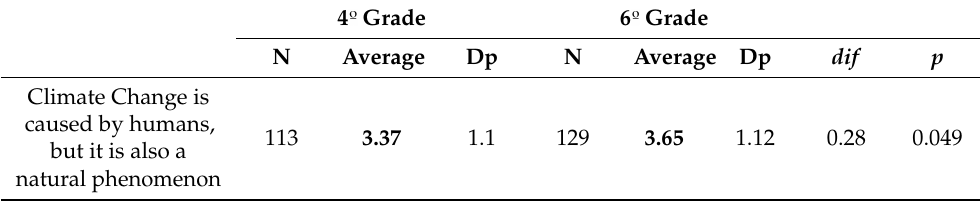
Table 7. Frequency table, grade 4 vs. grade 6, regarding the question: Climate change is caused by humans, but it is also a natural phenomenon. N = 242.